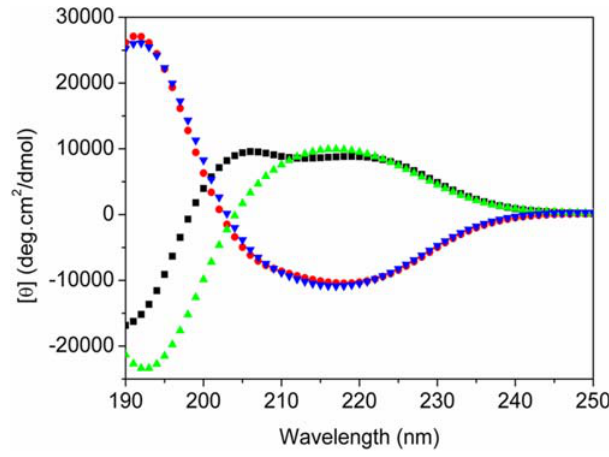
Figure 6. Comparison of structural behaviors of d-EAK16 and l- EAK16. Although both peptides have identical sequences, their chiral amino acids are mirror images. In l-EAK, there was no obvious structural change at 110 u C and return to 25 u C (red and blue). On the other hand, d-EAK16 exhibited drastic structural change at 110 u C and back to 25 u C. Initially at 25 u C, it had a beta-sheet structure (green spectrum); however, after heating, it converted to typical alpha-helix structure and remained stable even after cooling to 25 u C (black